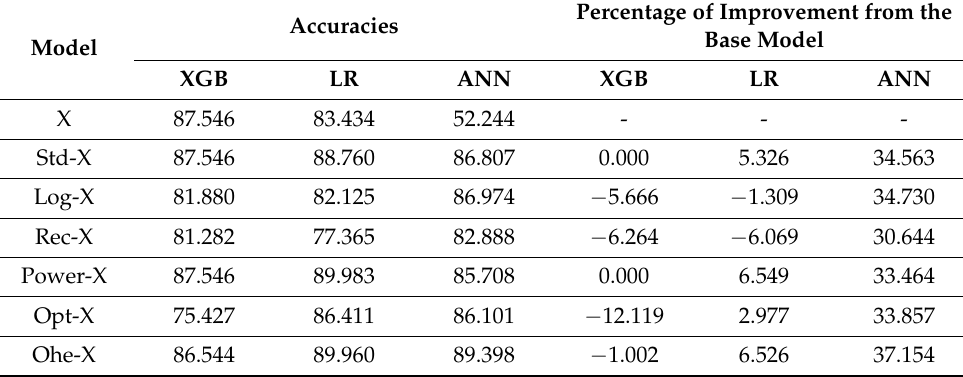
Table 3. Result of 10-cross-validation accuracy for XGB, LR, and ANN models by implementing different feature transformation